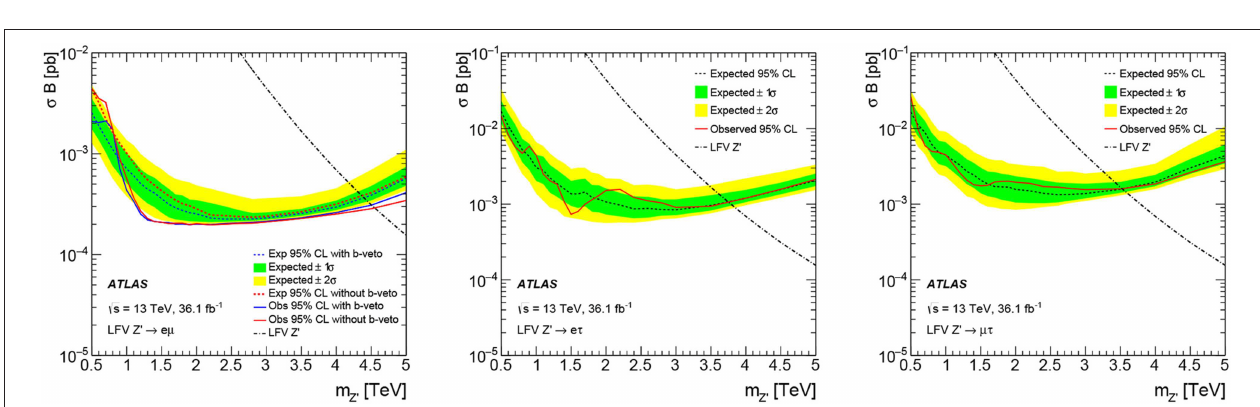
FIGURE 9 | The observed and expected 95% CL upper limits on the Z ′ boson production cross-section times branching fraction for decays into e µ (left), e τ (middle), and µτ (right). The signal theoretical cross-section times branching fraction, shown with dash-dotted lines, are obtained from MC simulations according to the LFV Z ′ ll ′ ) model ( B ( Z ′ 6.4 % ). The expected limits are shown with 1 and 2 standard deviation uncertainty bands. Reproduced from ATLAS Collaboration [ 63] under → = ± ± the Creative Commons CC-BY-4